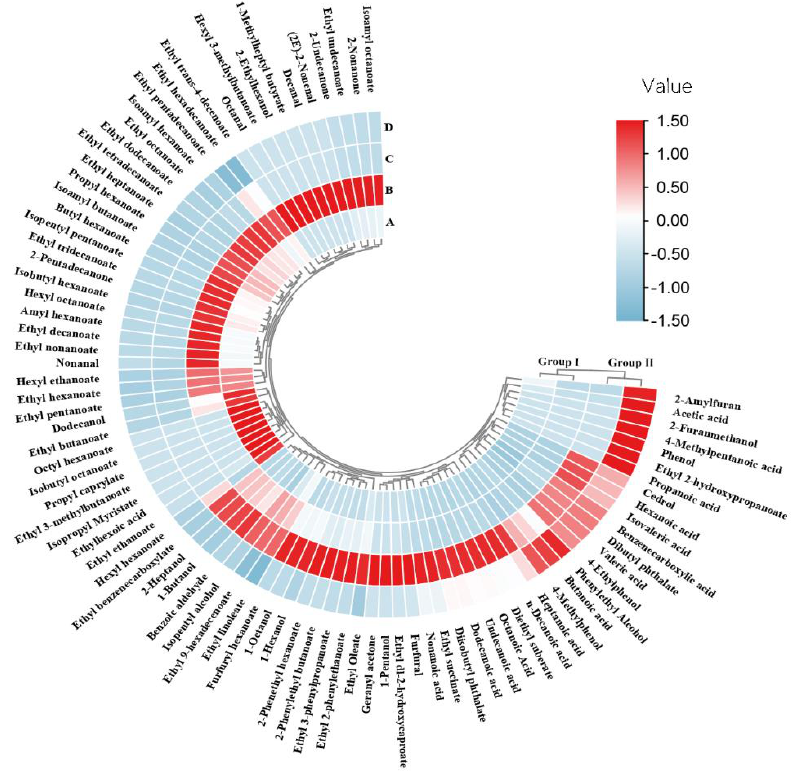
Figure 2. Heat map of aroma compound content of the four fractions distilled from (vacuum condition: A-800 hPa, B-600 hPa, C-400 hPa, D-200 hPa) Baijiu sample S1. Group I and Group II are distinguished by cluster analysis of composition of different fractions: fraction A and fraction B were clustered into Group I, indicating that the two fractions had similar composition (Group II in the same way). Value: standardized value of the concentration of